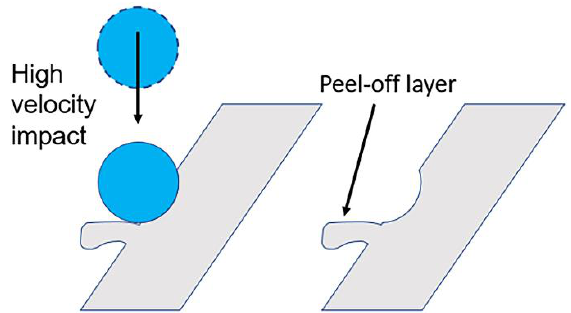
Figure 6. Mechanism of peel-off layer formation.